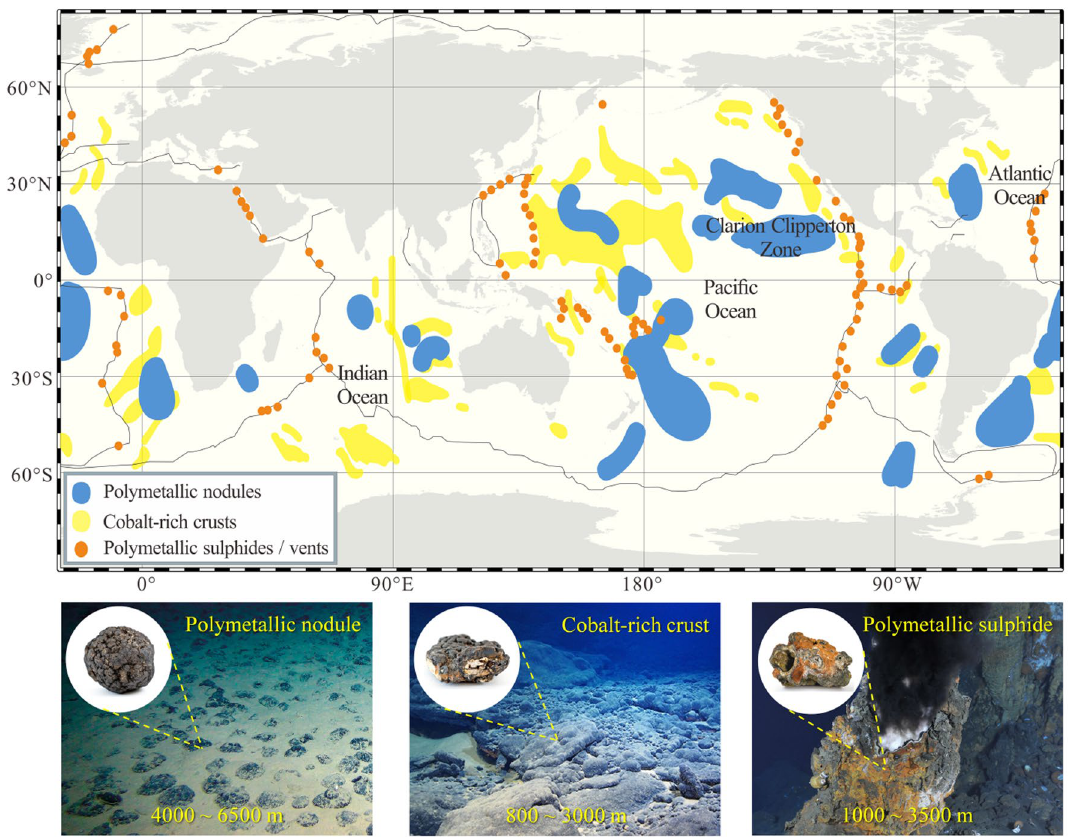
Fig. 1 Global distribution, occurrence state, and representative images of three major deep seabed mineral resources (modified from Miller et al. 2018; Cuyvers et al. 2018; photos taken by ROV KIEL